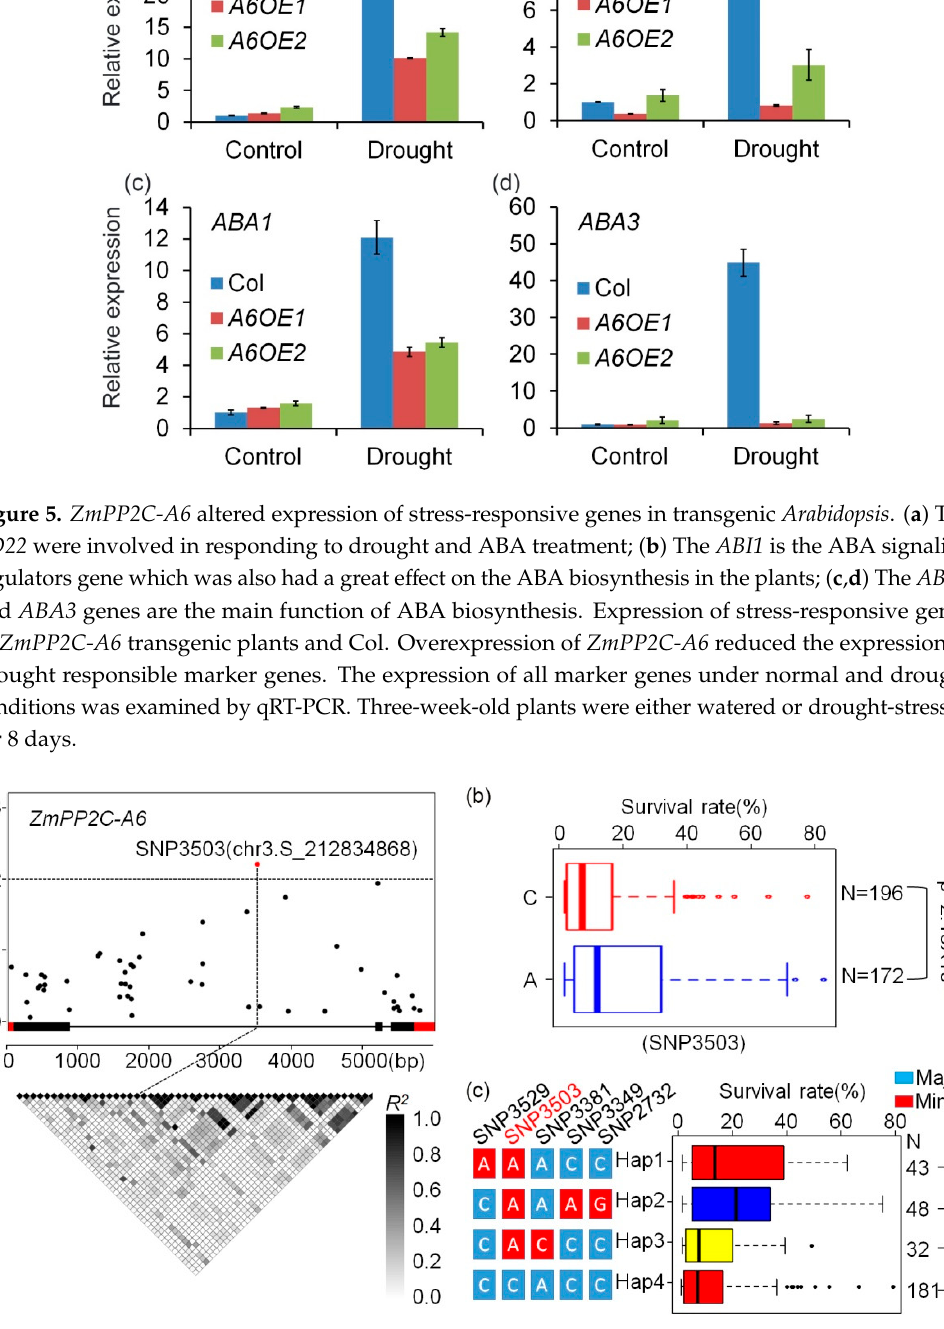
Figure 6. Association analysis of ZmPP2C-A6 natural variations with drought tolerance. ( a ) ZmPP2C-A6 association analysis and pairwise linkage disequilibrium (LD) among the SNP markers. The significantly associated SNPs are shown in red ( p < 0.01). The gene structure is shown in the middle. Exons and introns are shown as filled boxes and dark lines, respectively. ( b ) Association of two alleles in SNP3503 with drought tolerance. ( c ) Association of haplotypes (Hap) in ZmPP2C-A6 with drought tolerance. ns. means no significant.